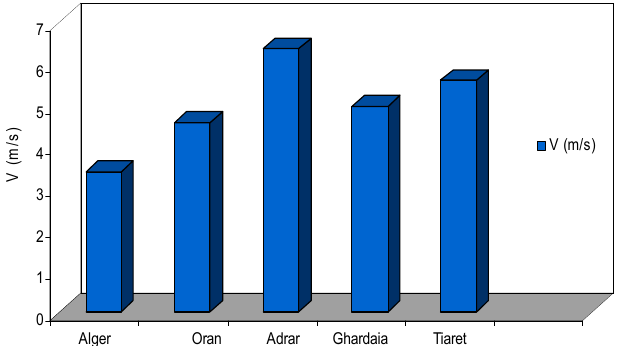
Figure 4. Annual wind speed in Algeria.